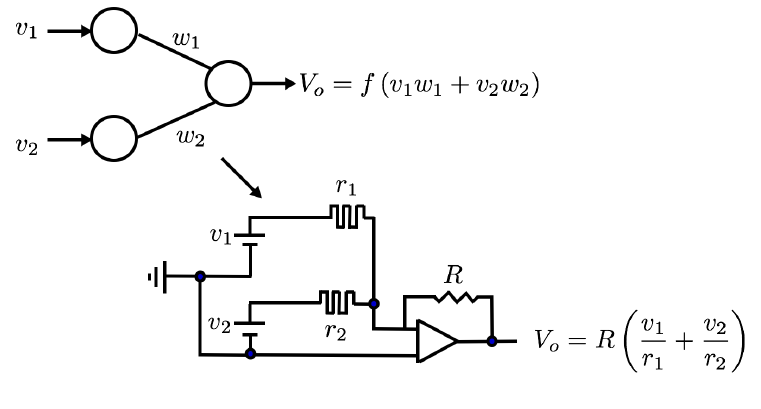
Figure 13. Memristor equivalent of a neural network with three neurons and two synapses, with an output amplifier.